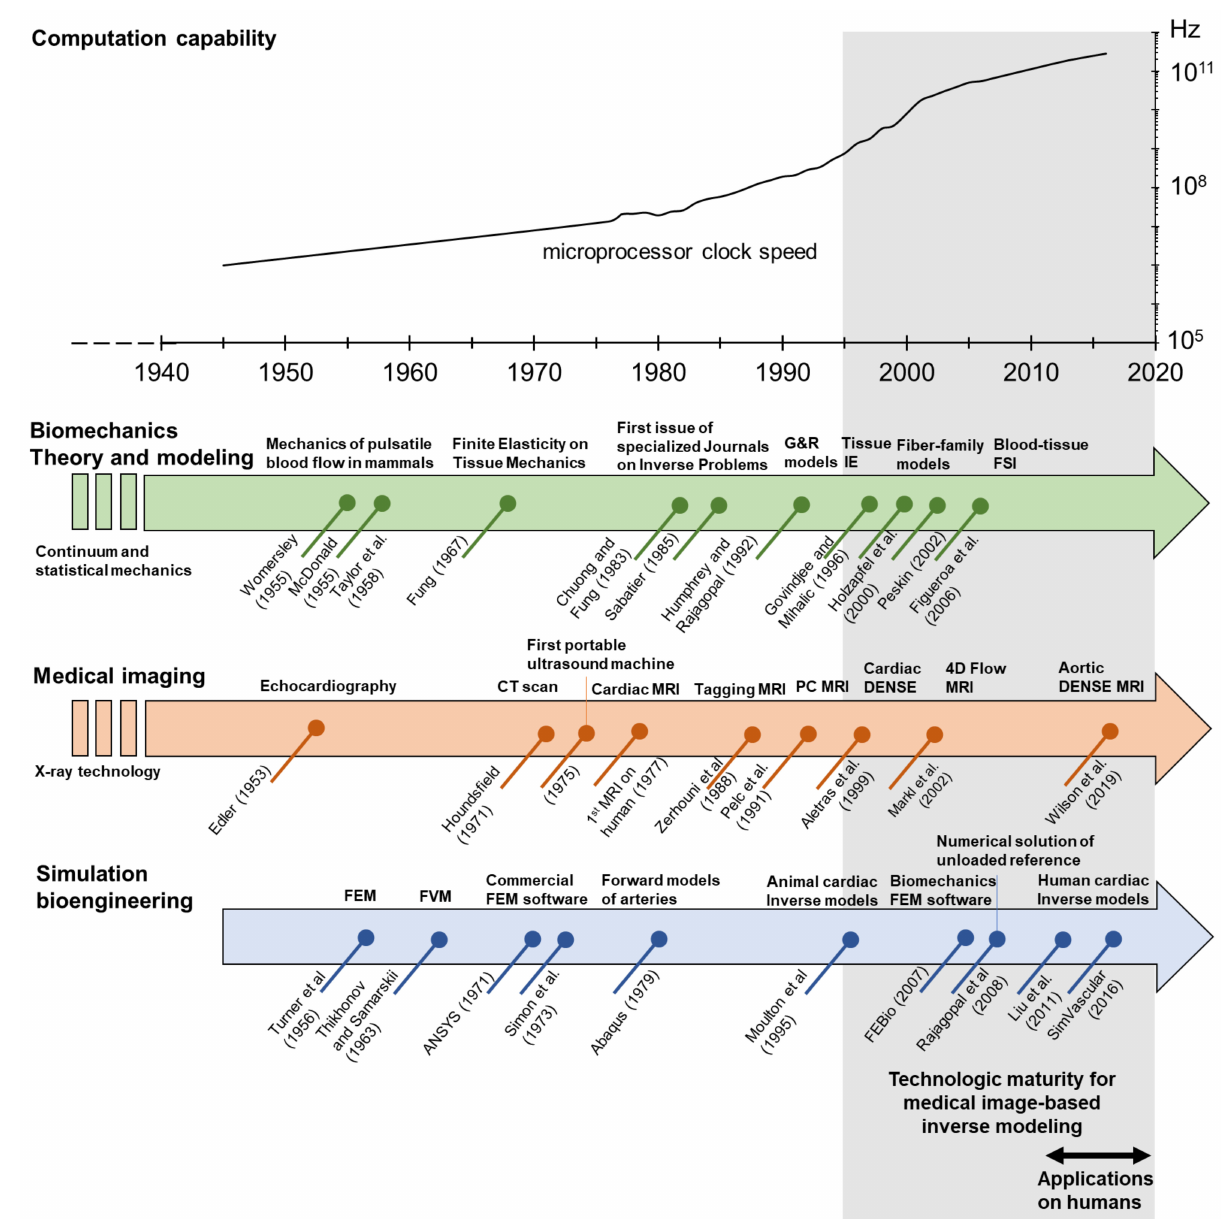
Figure 1. Timeline of microprocessor speed as a measure of computation capability, and relevant landmarks on the fields of biomechanics theory, medical imaging and simulation that make possible modern patient-specific image-based inverse modeling of the cardiovascular system. Acronyms: CT, computerized tomography; DENSE, displacement encoding with stimulated echoes; FEM, finite ele- ment method; FVM, finite volume method; IE, inverse elastostatics; FSI, fluid–structure interactions; PC, phase contrast; MRI, magnetic resonance